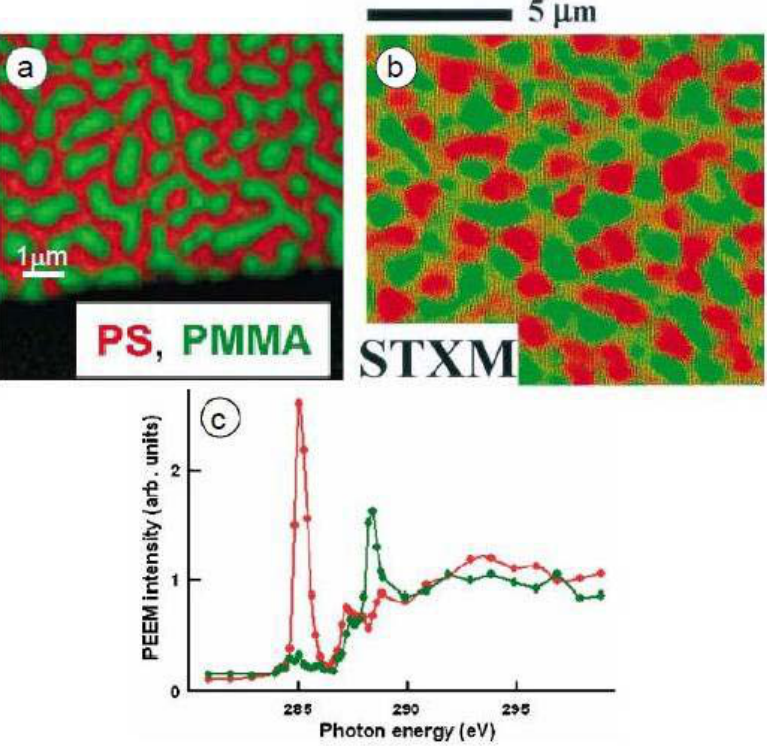
Figure 2 . Comparison of (a) X-PEEM and (b) STXM imaging for PS/PMMA 30:70 w/w. (c) C 1s NEXAFS spectra of PS (red) and PMMA (green) recorded in PEEM2